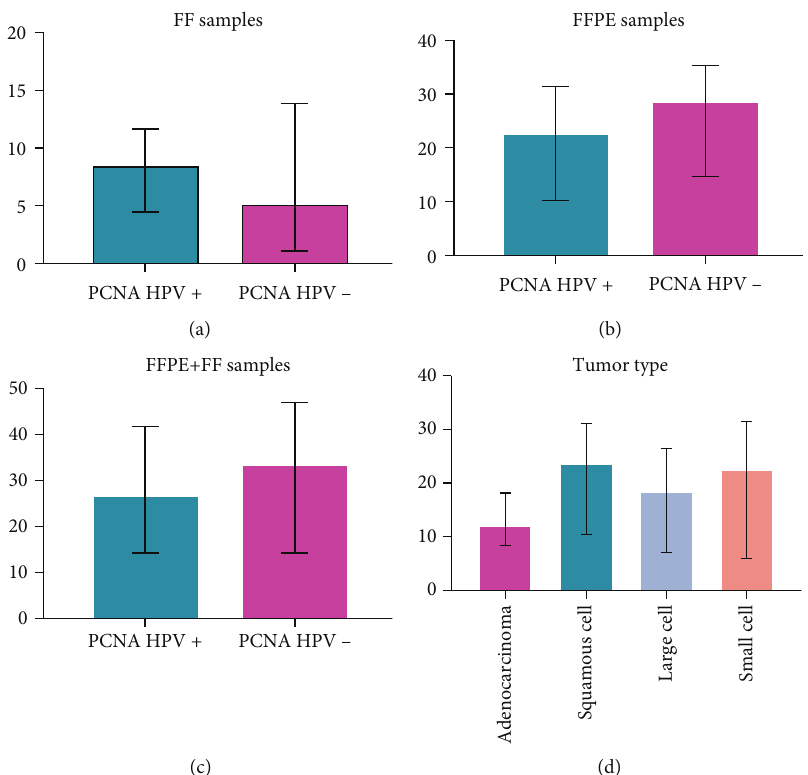
Figure 3: (a) PCNA expression in HPV+ and HPV- FF samples. Rank plot from the Mann – Whitney test with median and interquartile range. No statistical signi fi cance was found for p < 0 : 05 between the medians: 0.0807 for HPV+ and 0.0418 for HPV-; (b) PCNA expression in HPV+ and HPV- FFPE samples. Rank plot from the Mann – Whitney test with median and interquartile range. No statistical signi fi cance was found for p < 0 : 05 between the medians: 1.682 for HPV+ and 2.103 for HPV-. (c) PCNA expression in HPV+ and HPV- FFPE and FF samples. The expression medians were 0.5560 for HPV+ and 1.546 for HPV-. The Mann – Whitney analysis was performed, and no statistical di ff erence was found for p < 0 : 05 . (d) PCNA expression distribution in all types of tumors — median and interquartile rank analysis by the Kruskal-Wallis test. Medians of PCNA expression were as follows: adenocarcinoma 1.231; squamous cell carcinoma 2.293; large cell carcinoma 1.746; and small cell carcinoma 2.240. No signi fi cant di ff erence was found for p < 0 : 05